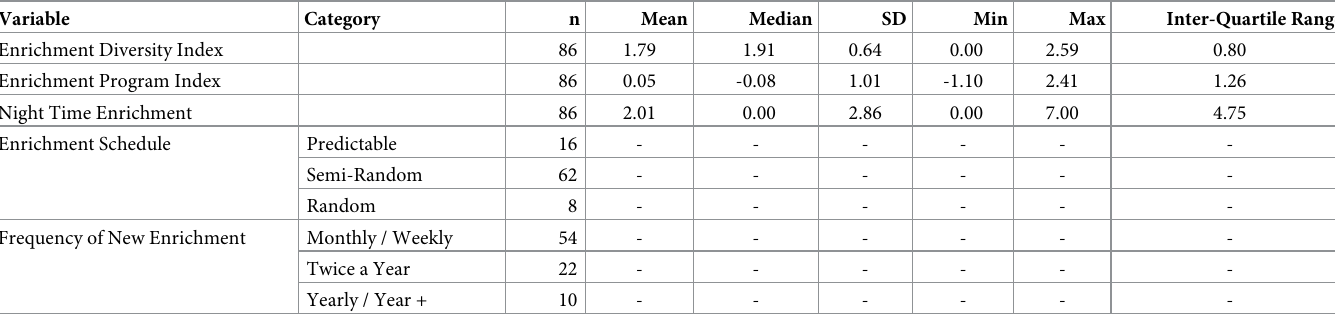
Table 3. Environmental enrichment variables.